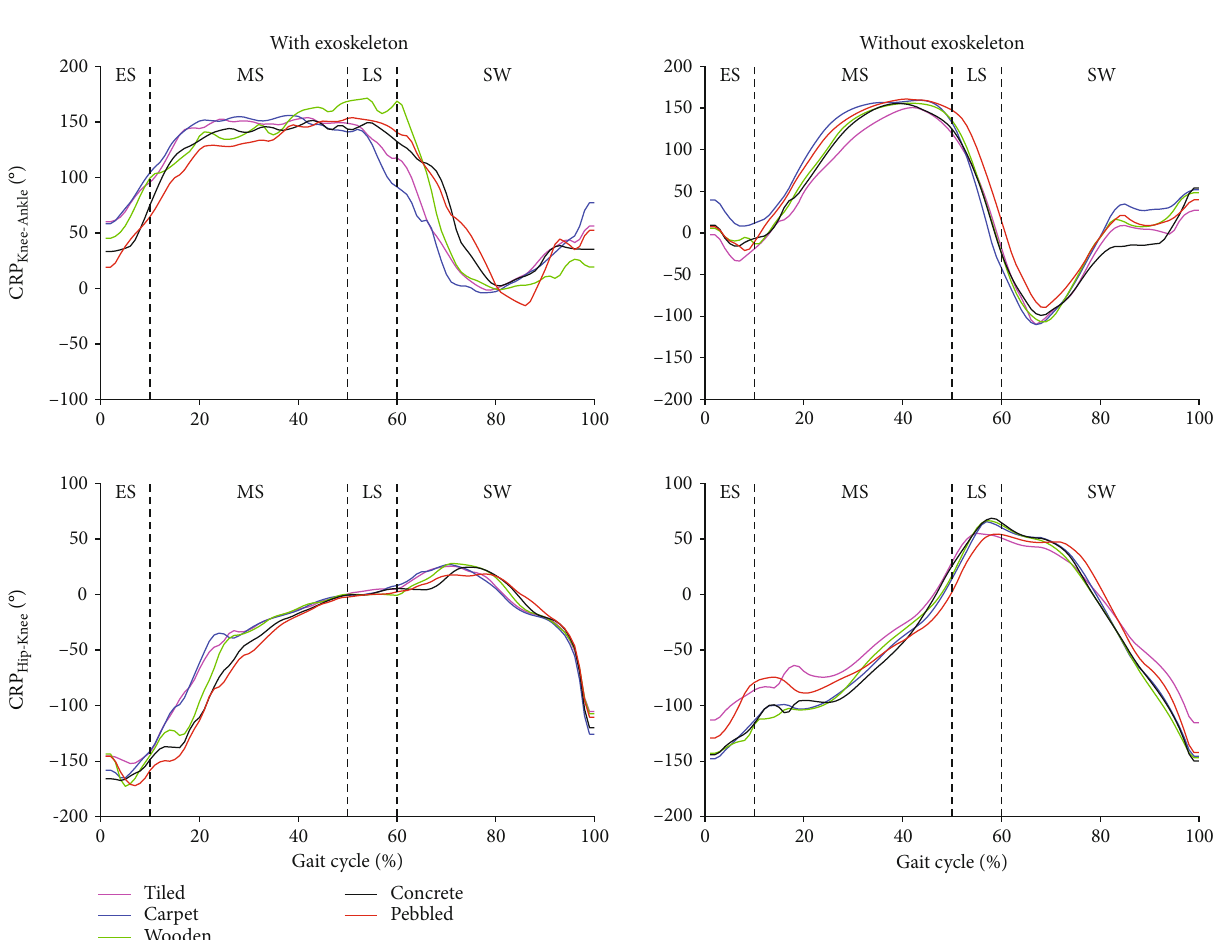
Figure 3: Continuous relative phase (CRP) patterns between the knee and ankle and between the hip and knee in the sagittal plane. Mean CRP for participants ( n = 8 ) with/without exoskeleton over the gait cycle on each kind of pavements. The gait cycle is from the heel strike to the next heel strike of the left foot. ES =early stance; MS = midstance; LS= late stance; SW= swing